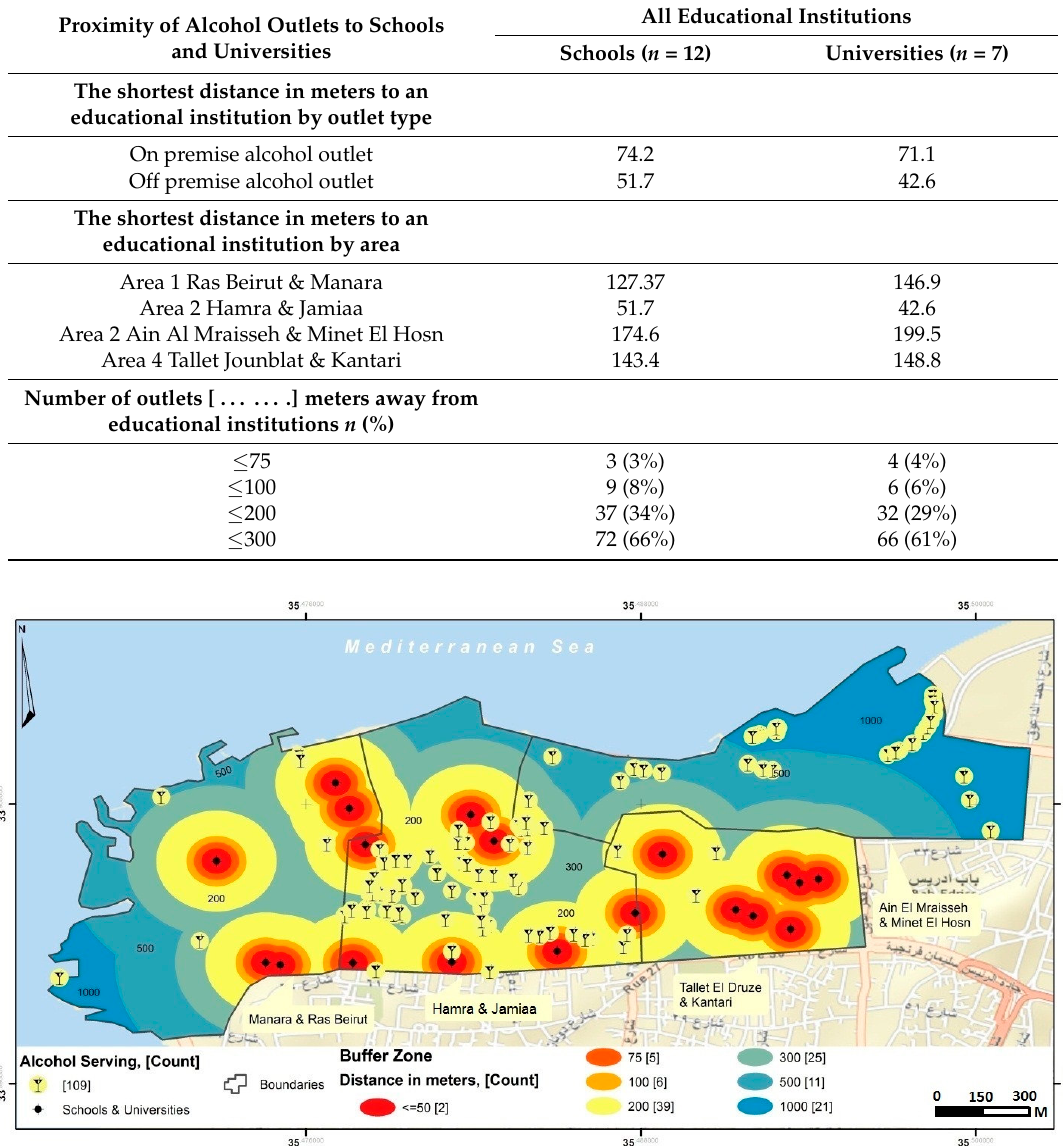
Table 3. Distance between alcohol outlets and educational institutions.